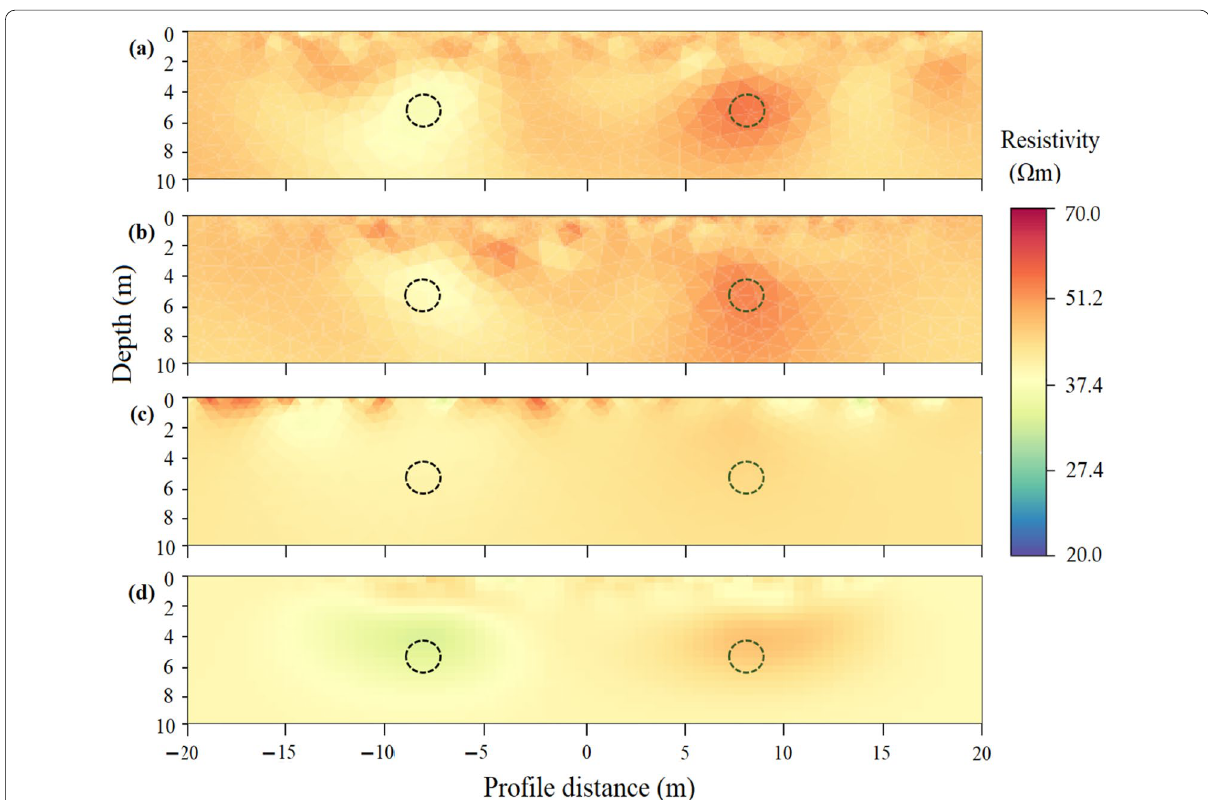
Fig. 11 The inverted model of scenario three for a 1 m target radius located at 5 m depth using the inversion freeware: a pyGIMLi, b BERT, c ResIPy, and d SimPEG. The broken circles indicate the actual targets; the left for conductive while the right for resistive target. Unstructured triangular mesh is implemented in pyGIMLi, BERT, and ResIPy, whereas tensor mesh is used in